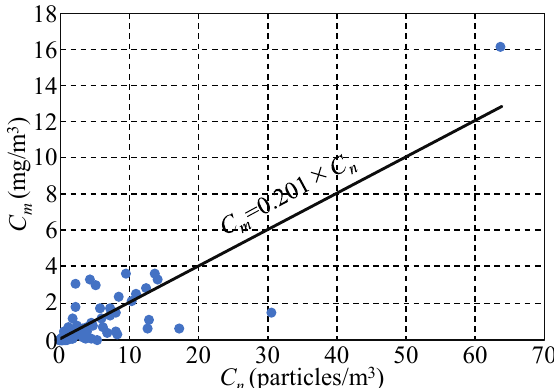
Figure 4. Relationship between the MicP numerical concentration C n and mass concentrations C m for all data. The solid line represents a linear approximation of the data and the regression coefficient (= 0.201 (mg/particle)) corresponds to the mean mass (mg) per MicP particle.